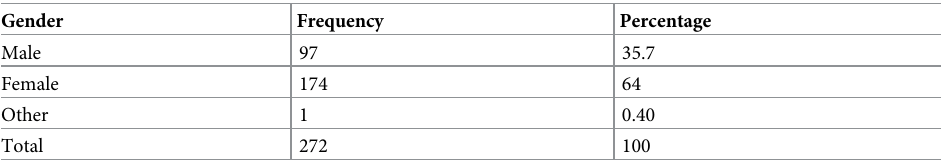
Table 4. Gender ratio (N = 272).